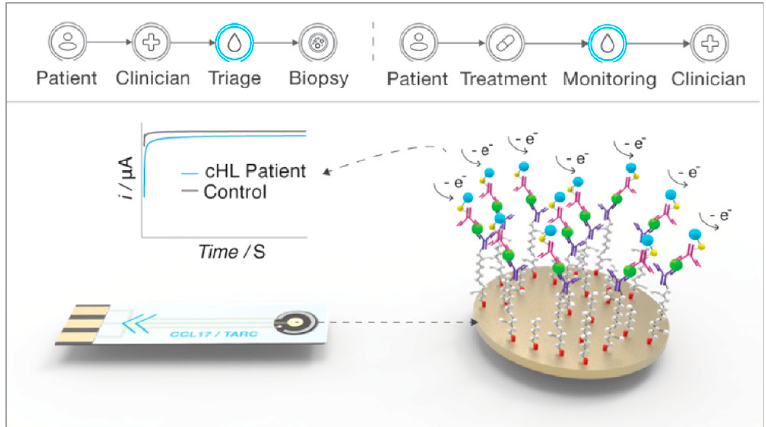
Figure 3. Schematic illustration of electrochemical immunosensor as a point-of-care test for detecting CCL17/TARC [72], reprinted with permission from American Chemical Society.